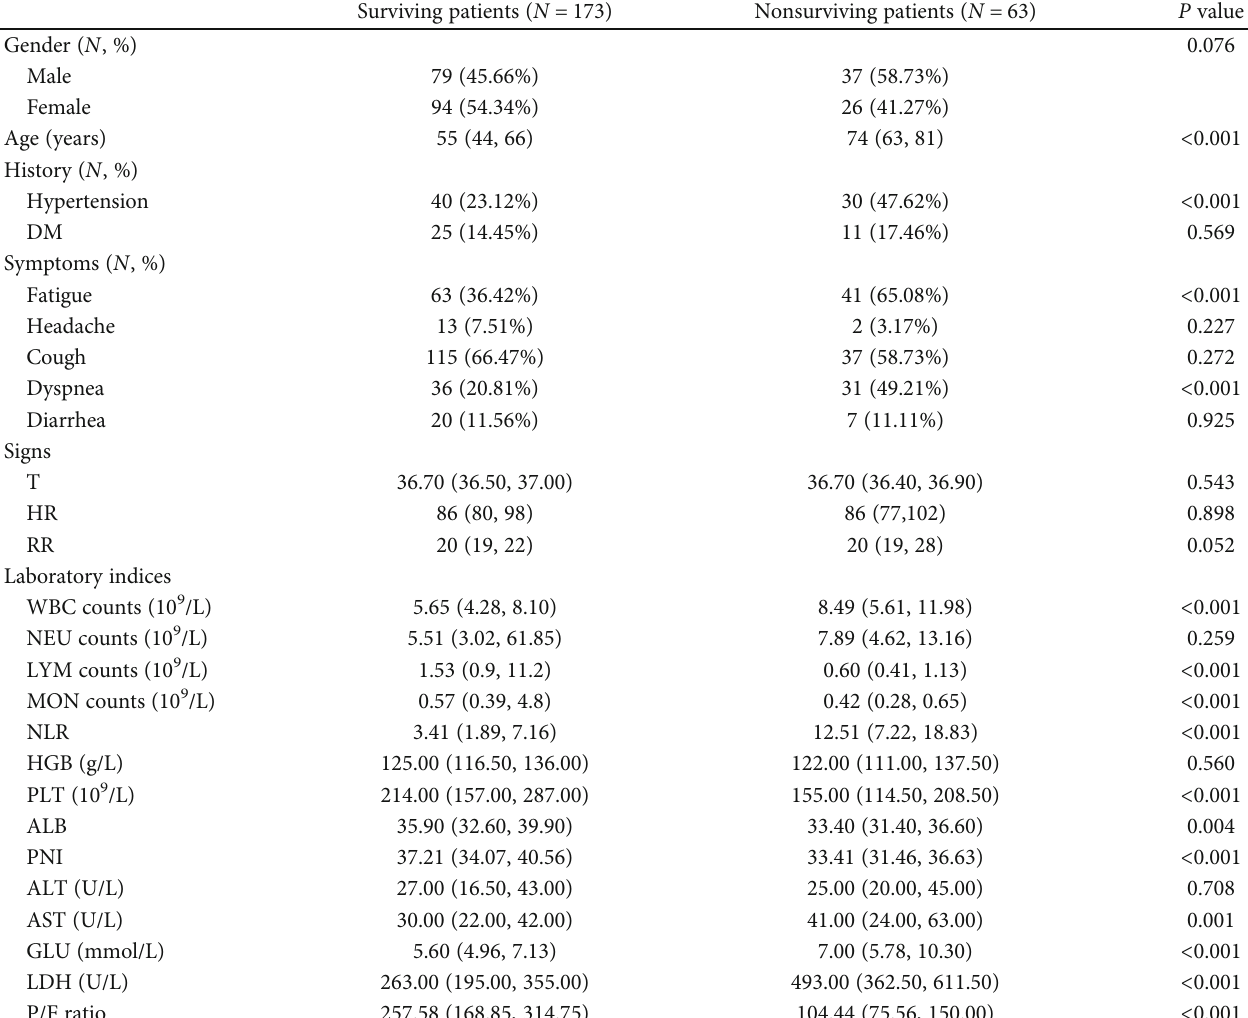
Table 2: Clinical characteristics of surviving and nonsurviving patients in the training cohort.